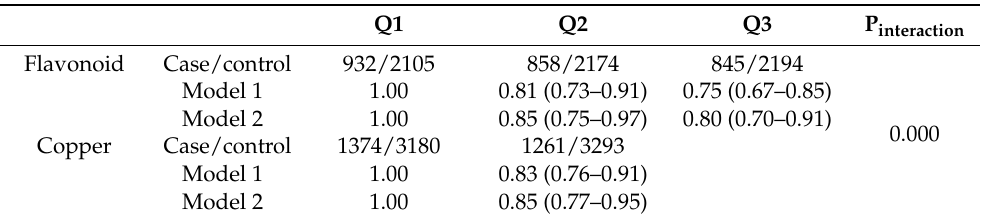
Table 4. ORs and 95% CIs of MetS risk scores by tertile of energy-adjusted flavonoid intake and secondary to energy-adjusted copper intake.